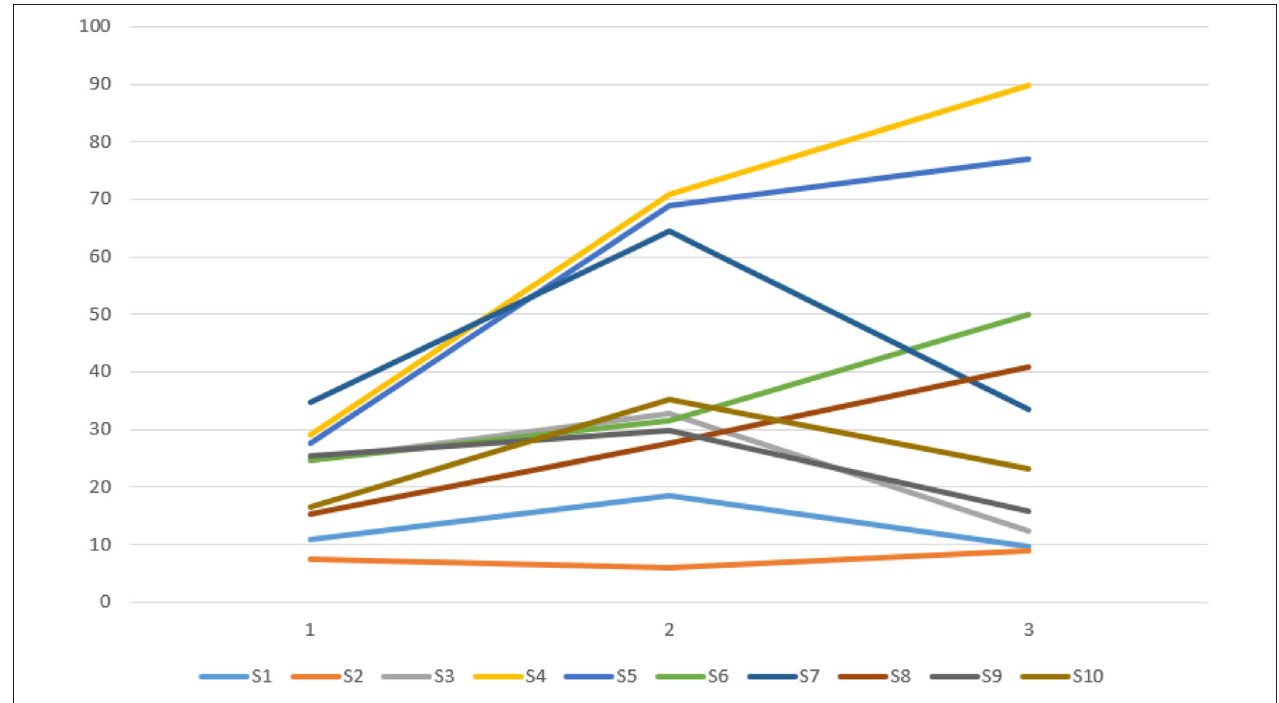
FIGURE 5 | Relationship between fatigue changes over time in 10 young subjects.